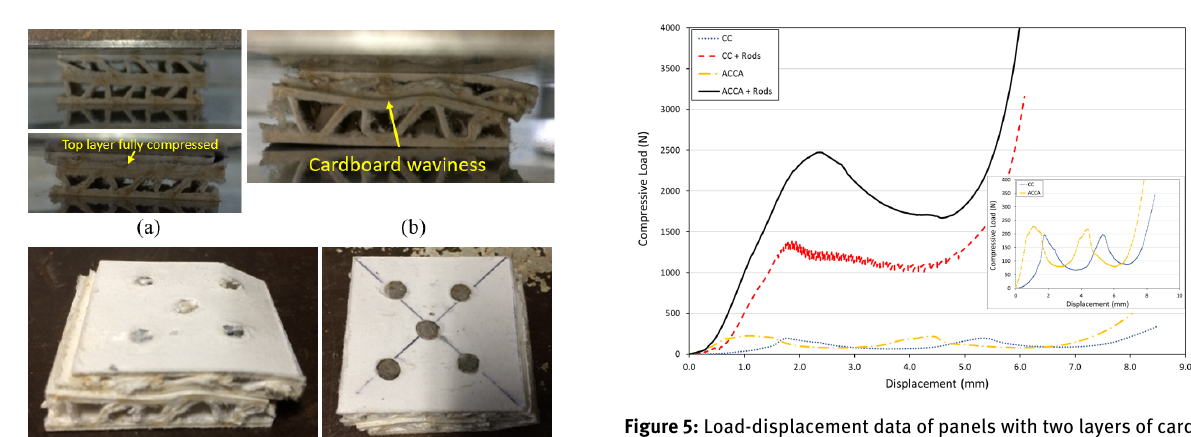
Figure 5: Load-displacement data of panels with two layers of card- board (CC) with and without rods, and two-layers of cardboard and two layers of aluminum in a aluminum-cardboard-cardboard- aluminum stacking structure (ACCA) with and without rods.